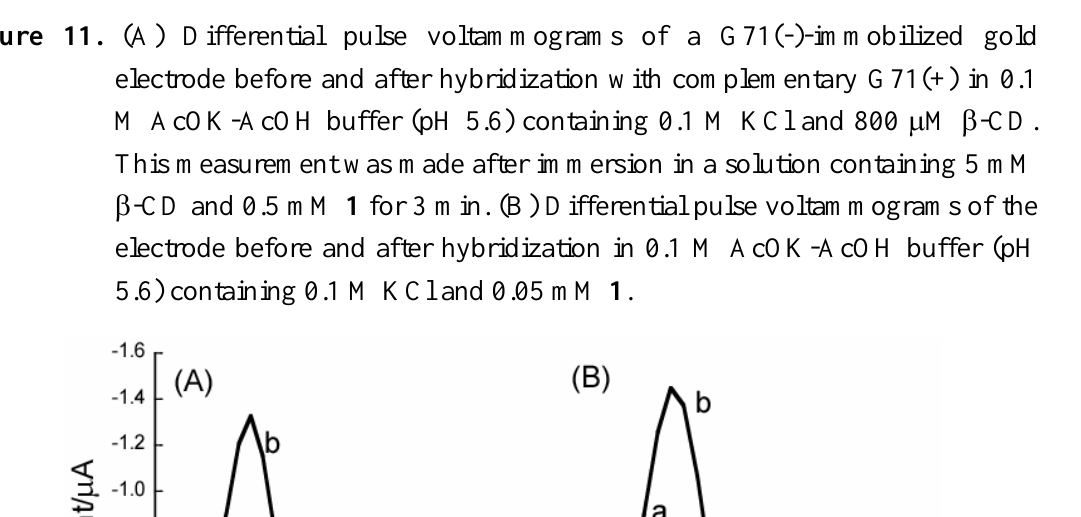
Figure 11. (A) Differential pulse voltammograms of a G71(-)-immobilized gold electrode before and after hybridization with complementary G71(+) in